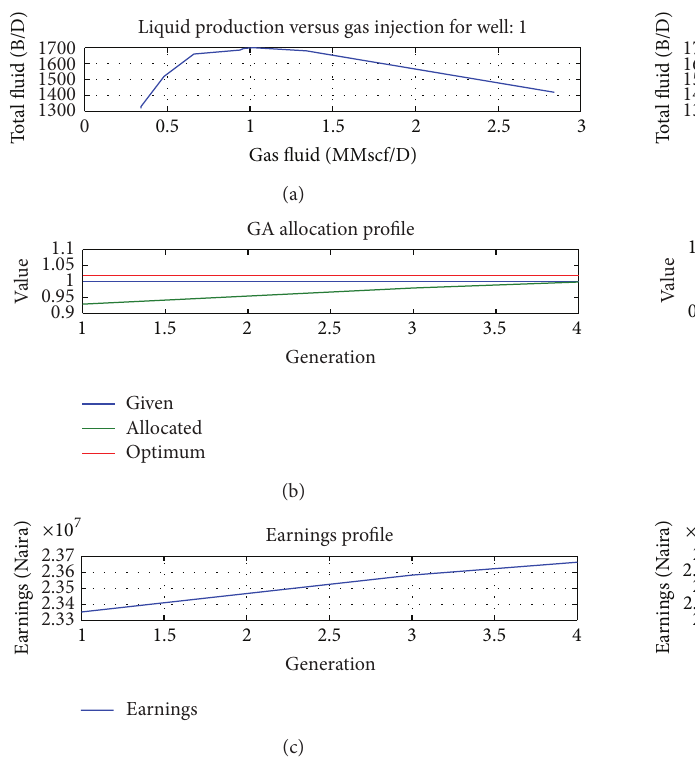
Figure 6: Well 1’s allocation profile, GA allocation profile, and the earnings (Naira) profile for a limited scenario.